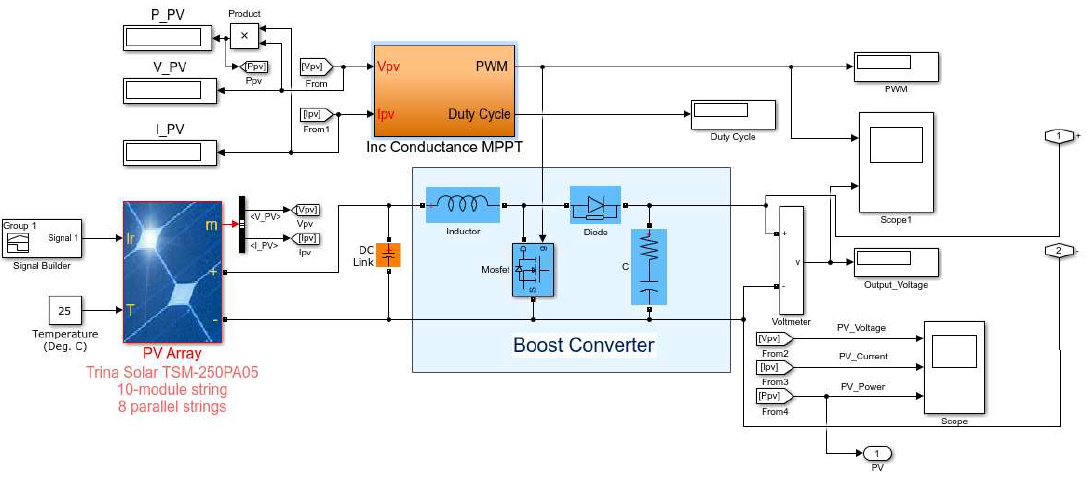
Figure 11. PV Simulink model.